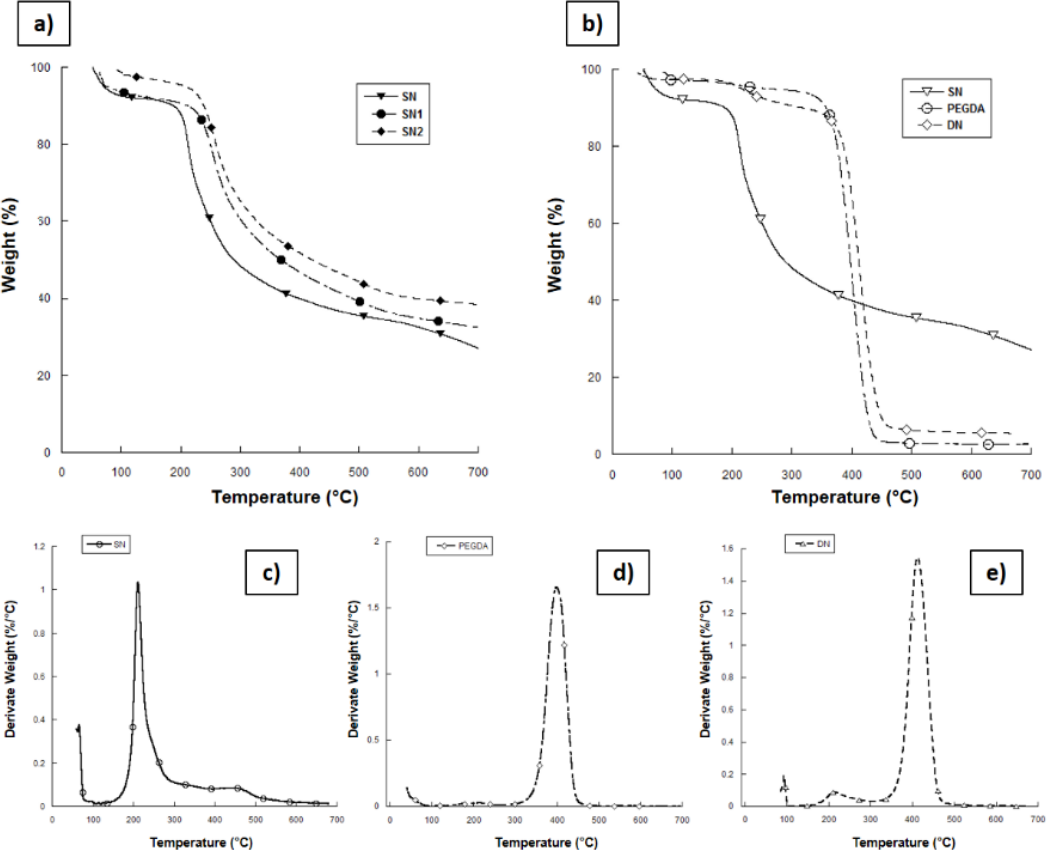
Figure 2. Results from thermogravimetric analysis (TGA) on lyophilized hydrogel samples. ( a ) Comparative curves for single network (SN) samples with different amounts of HAp; ( b ) comparative curves between SN, double network (DN) and poly(ethylene glycol) diacrylate (PEGDA) crosslinked materials; ( c – e ) derivative mass curves of SN, PEGDA, and DN hydrogels, respectively.